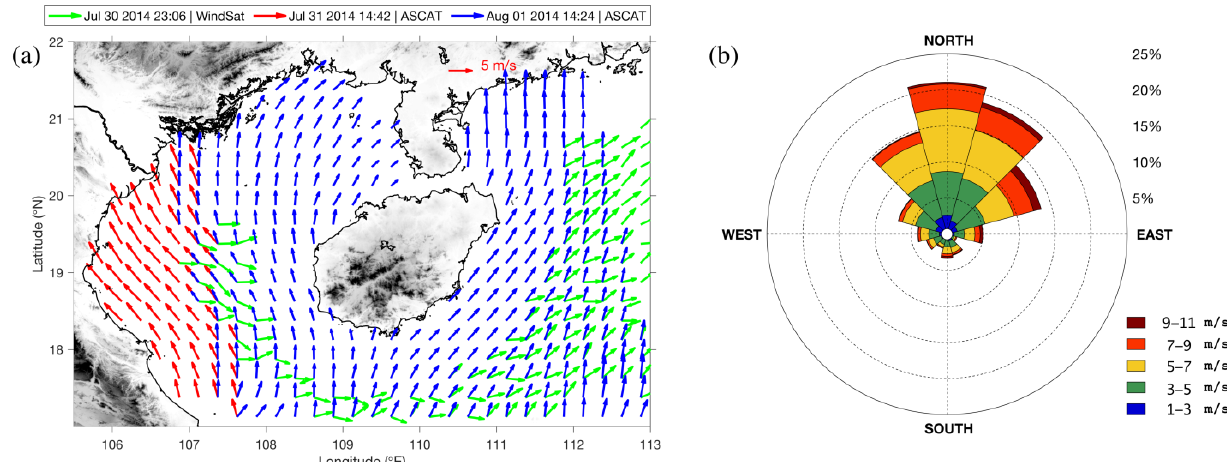
Figure 2. ( a ) Wind vectors observed by WindSat and ASCAT-A from 30 July to 1 August 2014. ( b ) The wind rose in the studied area based on the NCEP reanalyzed wind data for June–August 1998–2018. Note: wind direction follows oceanological convention.